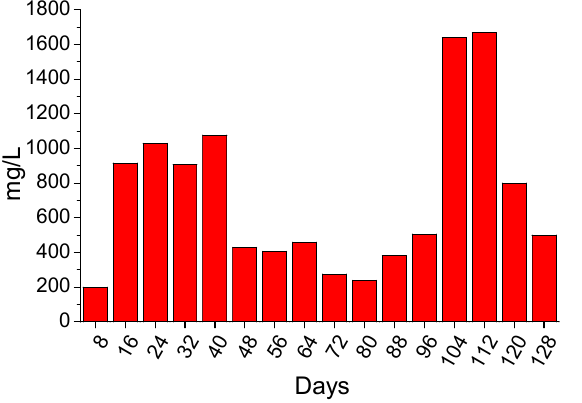
Figure 9. The evolution of magnesium content (mg/L) of rinsing liquids at 8-days intervals during the application of long duration acid spraying test.